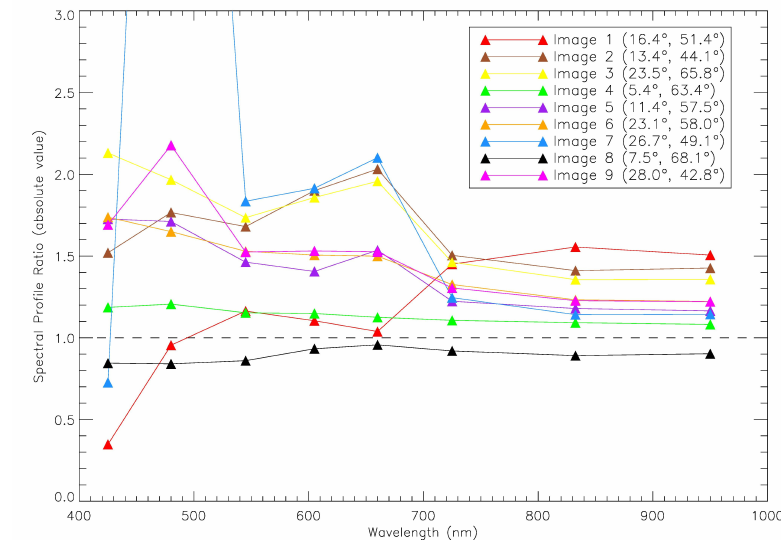
Figure 2. Comparison between the spectral profile ratio (un-sharpened over pan-sharpened) of vinerows imaged under different conditions. Off-nadir angles and solar elevation angles, respectively, are given for each image profile in brackets. All profiles showed a strong vegetation signature in both pan-sharpened and un-sharpened images (pixel counts are provided in Table A2). The dashed line at a spectral ratio of 1.0 indicates no spectral distortions introduced through the pan-sharpening process.